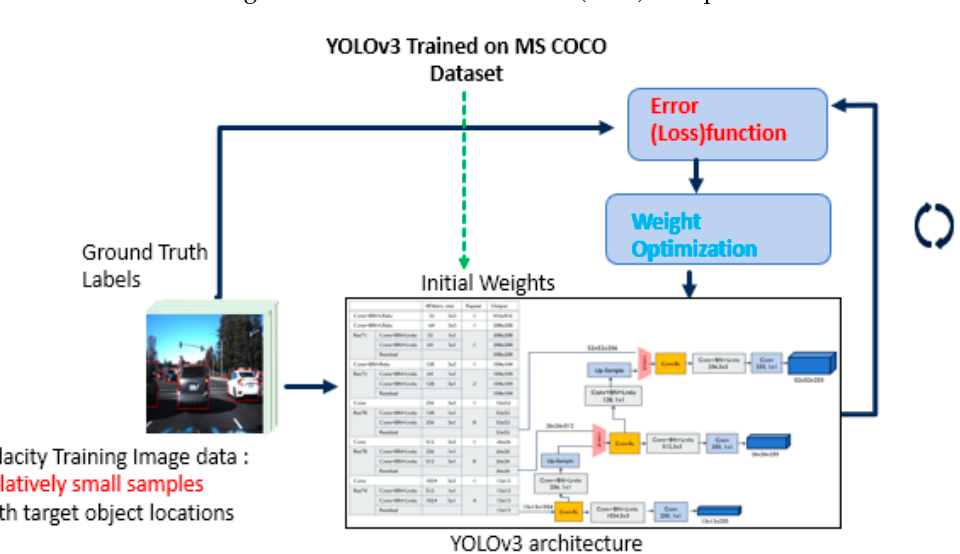
Figure 5. Transfer learning using the Udacity dataset.